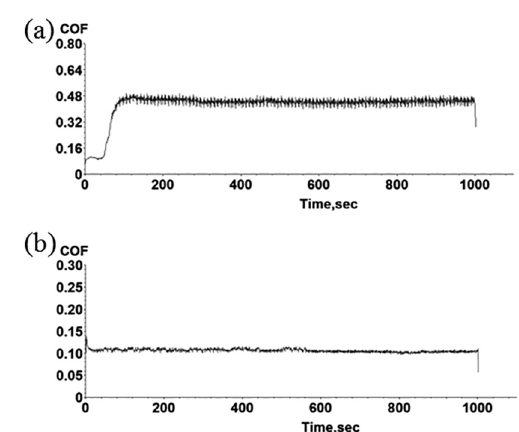
Figure 9: Friction coefficient graph of (a) uncoated sample (b) DLC